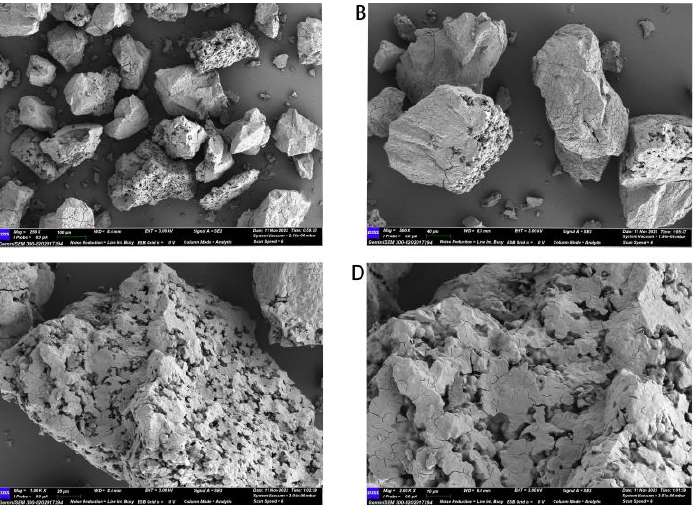
Figure 5. ( A ) SEM images of cMORP ×250; ( B ) SEM images of cMORP ×500; ( C ) SEM images of cMORP ×1000; ( D ) SEM images of cMORP ×2000.